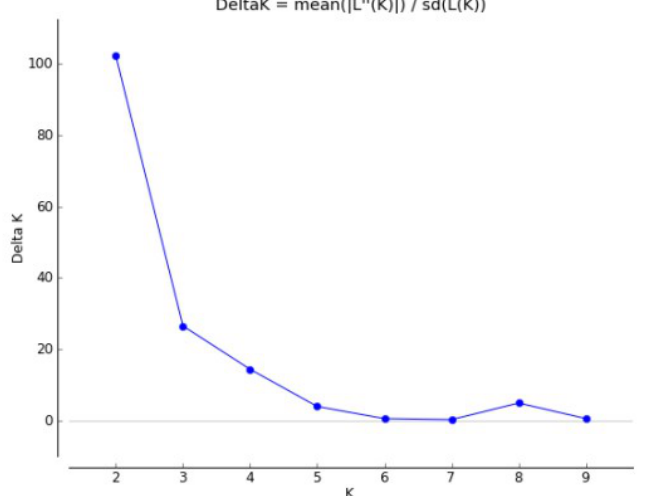
Figure 2. Delta Evanno statistics for number of presumed subpopulations ranging from 1 to 10 in the sunflower association panel.